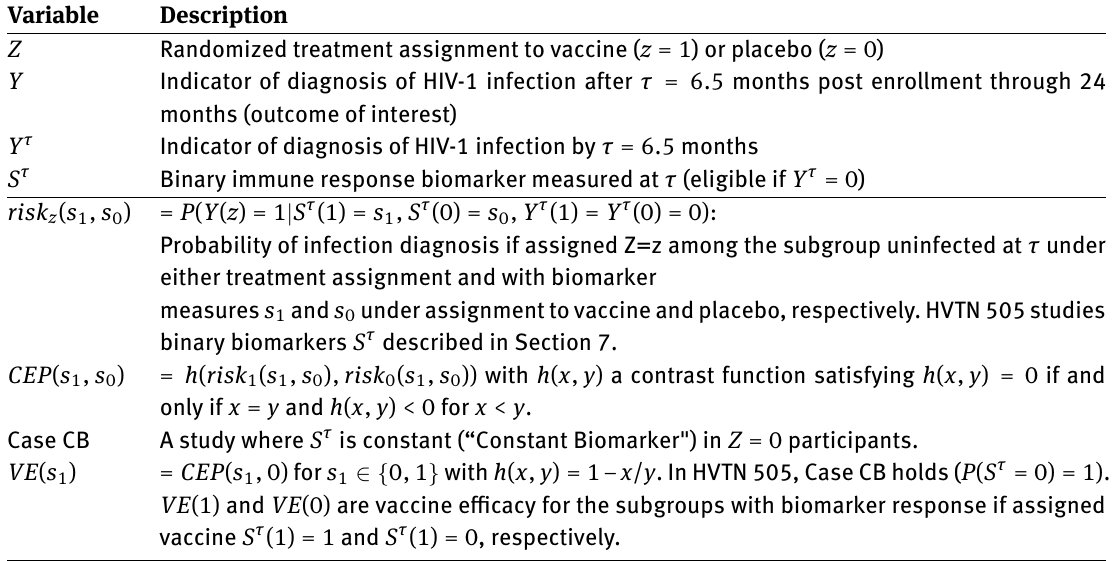
Table 1: Notation and Parameters of Interest for the HVTN 505 HIV-1 Vaccine Eflcacy Trial